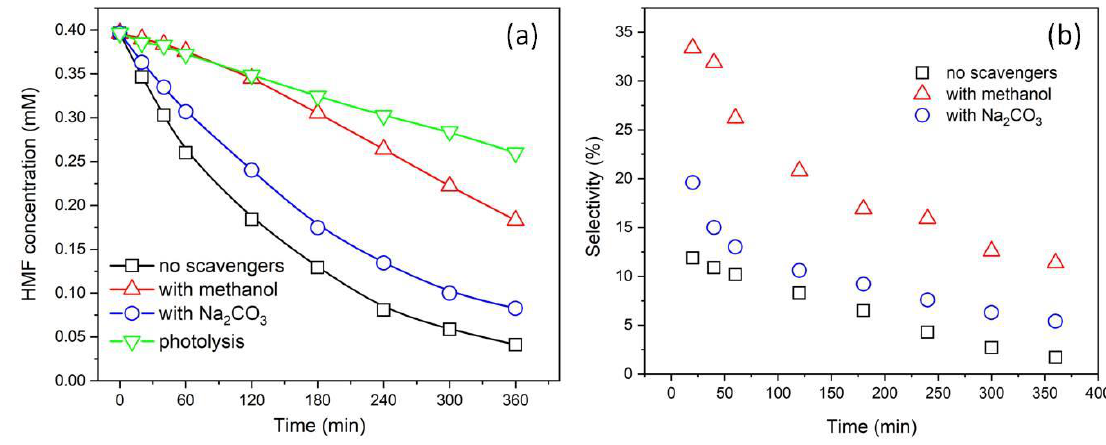
Figure 5. Effect of scavengers on 5-hydroxymethylfurfural (HMF) photocatalytic oxidation ( a ) and 2,5-diformylfuran (DFF) selectivity ( b ). Experimental conditions: light irradiation intensity 3.0 mW cm −2 , catalyst dosage 1 g L −1 , HMF concentration 0.4 mM, O 2 flow 3 mL min −1 .